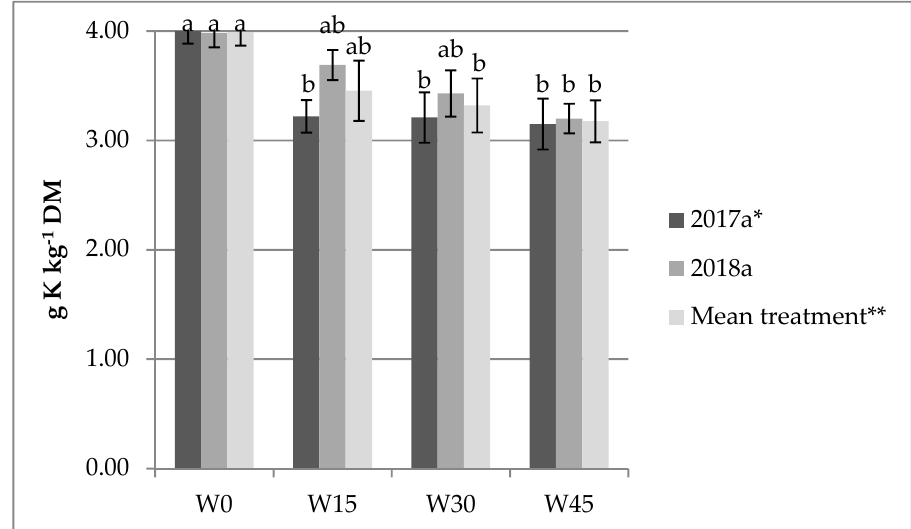
Figure 6. Potassium content in maize grain. W0—the control with no stillage treatment, W15—15 m 3 of stillage per hectare, W30—30 m 3 of stillage per hectare, W45—45 m 3 of stillage per hectare. * means of years regardless of treatments; ** means of treatments regardless of years. The same letter means not significantly di ff